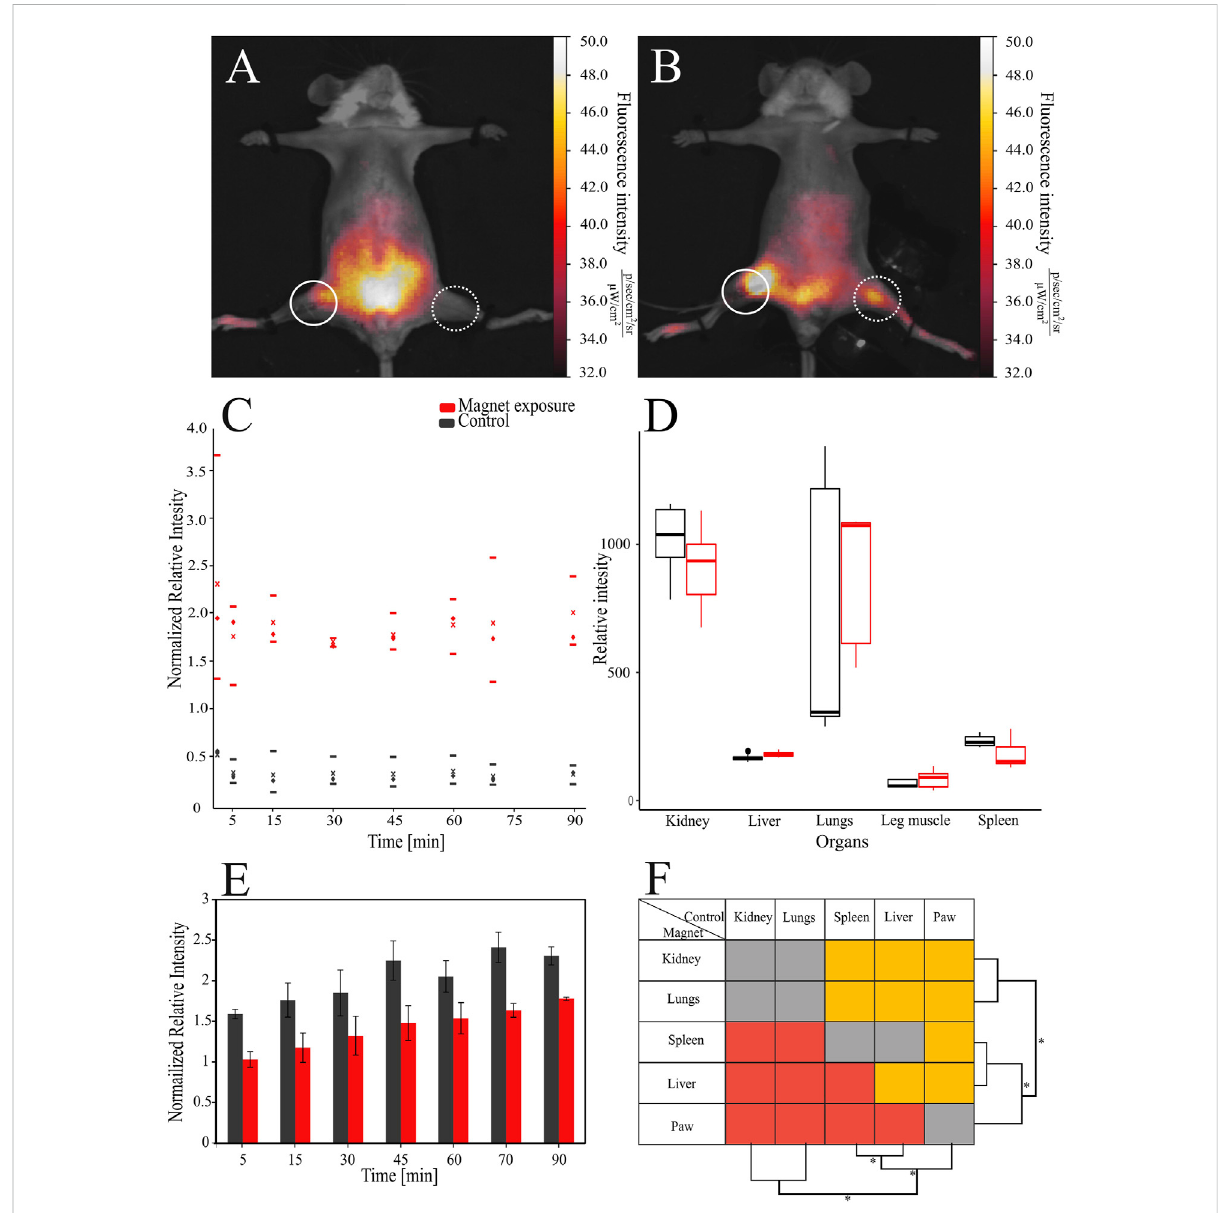
FIGURE 2 Distribution of the bacterial cells modi fi ed with magnetite nanoparticles and Cy-7 labeled PEI in mice. PEI = polyethylenimine. The bacteria were detected: (A) in control mice and (B) in exposed mice under the magnetic fi eld, respectively, dashed circles indicate injection site, solid circles theplace of cell collection. (C) The relative fl uorescence intensity ofthe signal in thepaw of mice exposed to the magnetic fi eld and control mice by blood fl ow was used to compare the accumulation of cells, where - median, x - average, upper and lower borders are 25 – 75th percentile respectively. (D) Normalized relative fl uorescence was also assessed in the organs of animals. (E) Introduction of bacteria led to increase of relative fl uorescenceintensitiesinmurinebodiesovertime. (F) Comparison ofrelativeintensitiesbetweendifferentorgans, red-signalofthemagnet group is lower than control, gray — insigni fi cant, orange —